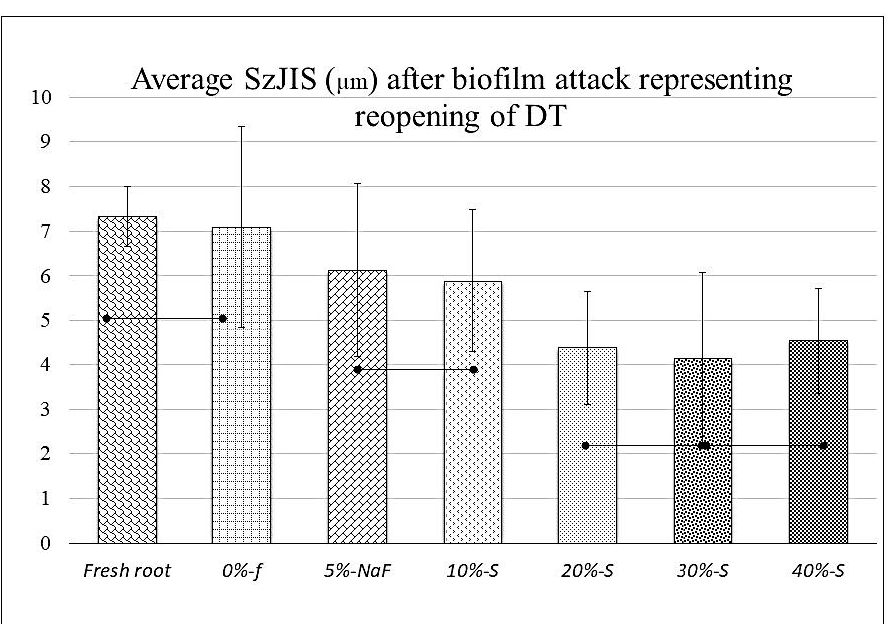
Figure 3. Graph of CLSM data representing depths of re ‐ opened DTs, mean value, and standard deviation for laser penetration depths for in vitro root dentin after 7 ‐ day biofilm test for control groups ( 0% ‐ f and 5% ‐ Naf ) and experimental groups ( 10% ‐ S , 20% ‐ S , 30% ‐ S , and 40% ‐ S ) . Laser penetration depth (SzJIS: μ m) was less significant in S ‐ PRG ‐ incorporated groups compared to control groups. (Dotted bars indicate no significant differences; p < 0.05).